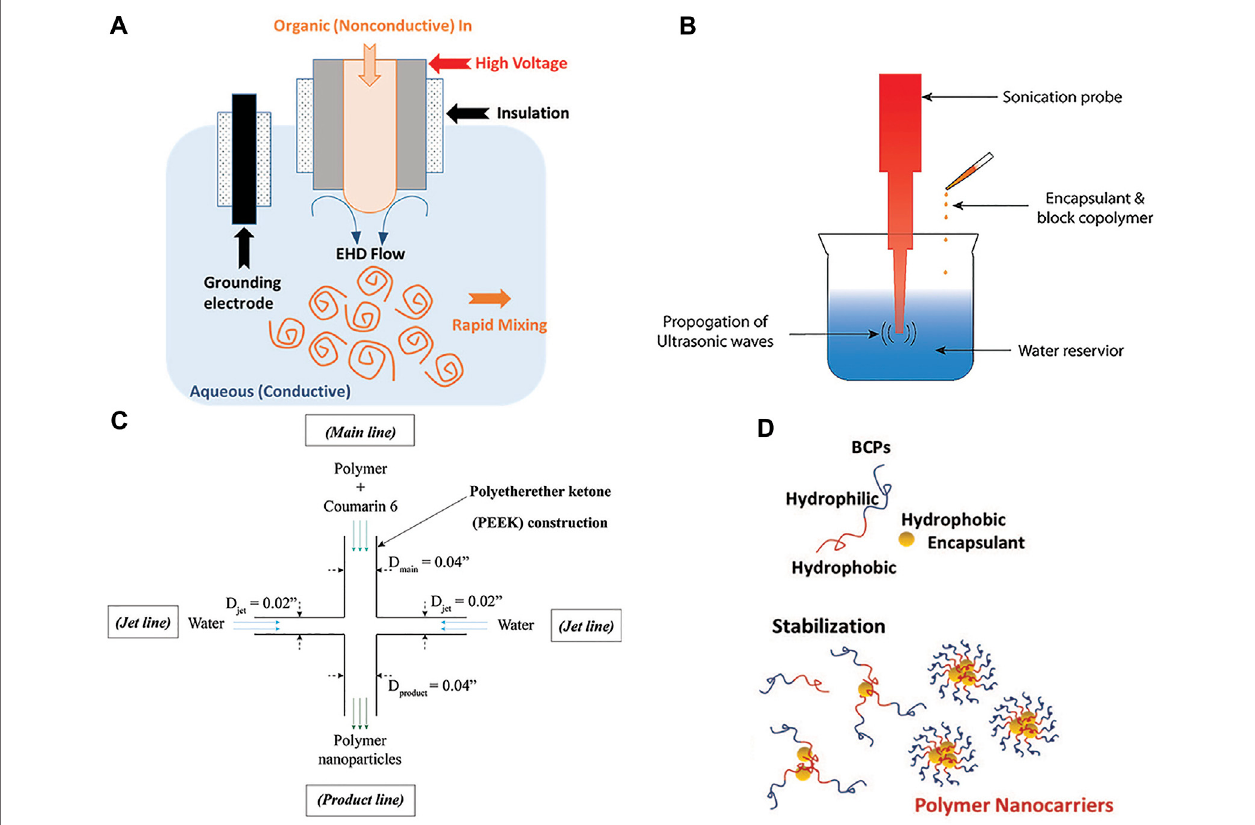
FIGURE 1 | (A) Schematic of electrohydrodynamic mixing-mediated nanoprecipitation (EM-NP) process for synthesizing polymer nanocarriers. In EM-NP, electrohydrodynamic (EHD) fl ow of the continuous aqueous phase is generated by applying a voltage across an electri fi ed needle and grounding electrode. EHD fl ow disperse the organic phase, containing block copolymers (BCPs) and encapsulants, which is simultaneously injected through the electri fi ed needle. As miscible organic and aqueous solvents are employed, BCPs and encapsulants achieve instantaneous high supersaturation resulting in encapsulant aggregation and subsequent BCP adsorption. (B) Schematic of sonication nanoprecipitation process. The aqueous phase was sonicated with a constant duty cycle while the organic phase was added. (C) Jet mixing reactor (JMR) schematic. The JMR was used to compare EM-NP to FNP processes and consisted of a main line (d main (cid:1) 0.04 ″ ) carrying polymer and drug, and two perpendicular jet lines (d jet (cid:1) 0.02 ″ ) carrying water. Jet lines intersect with the main line at right angles in the con fi ned JMR volume generating intense mixing. (D) Water miscible organic solvent containing BCPs and encapsulant are dispersed in water. BCPs and encapsulants achieve instantaneous high supersaturation resulting in encapsulant aggregation and subsequent BCP